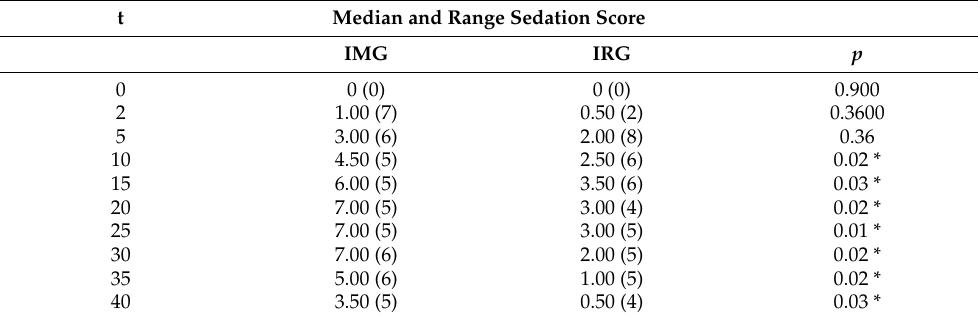
Table 4. Median and range of sedation score in comparison of group receiving intrarectal (IRG) and intramuscular (IMG) administration and relative p value. On the left: time post administration expressed in minutes. Range is reported between round brackets.